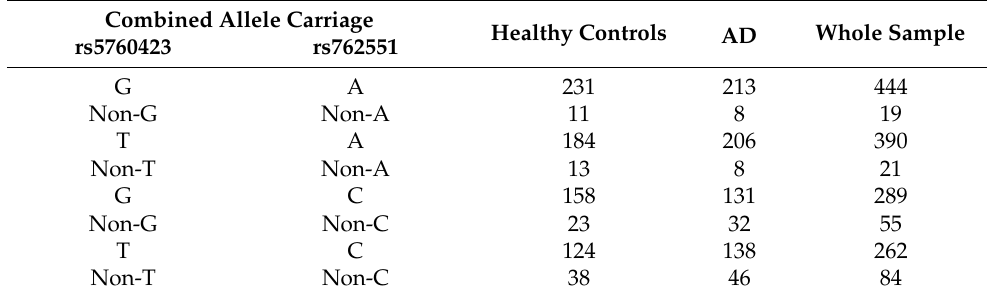
Table 5. Total numbers of individuals carrying allele–allele combinations of ADORA2A rs5760423 and CYP1A2 rs762551 in healthy controls, in AD cases, and in whole sample. Combined Allele Carriage